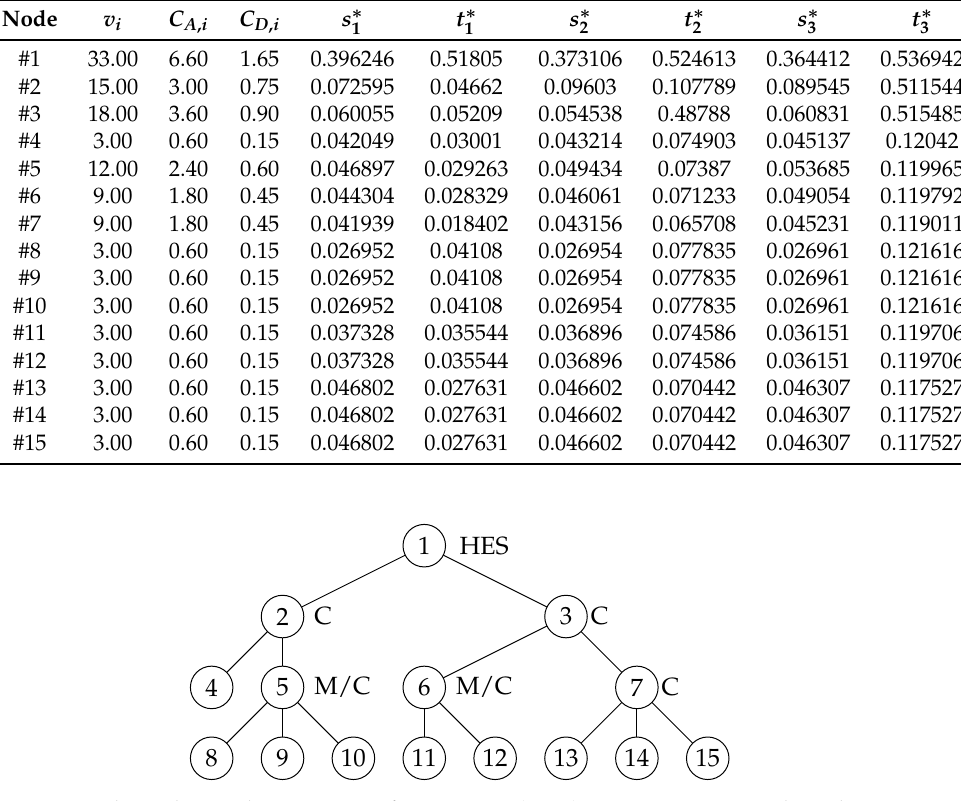
Figure 2. The Advanced Metering Infrastructure (AMI) tree structure used in the case study. It contains the head-end system (HES). The intermediate nodes are either pure Collectors (C) or hybrid Meter/Collectors (M/C). The leaf nodes are